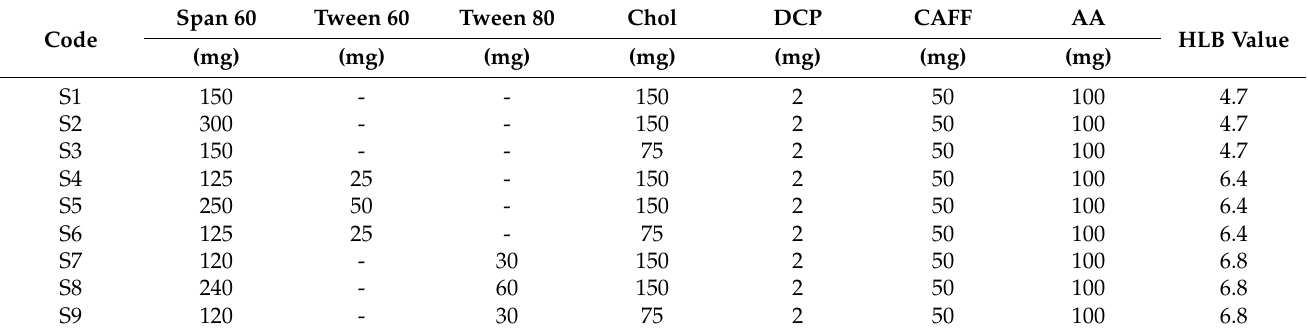
Table 1. The composition of AA and CAFF niosomal nanoparticle